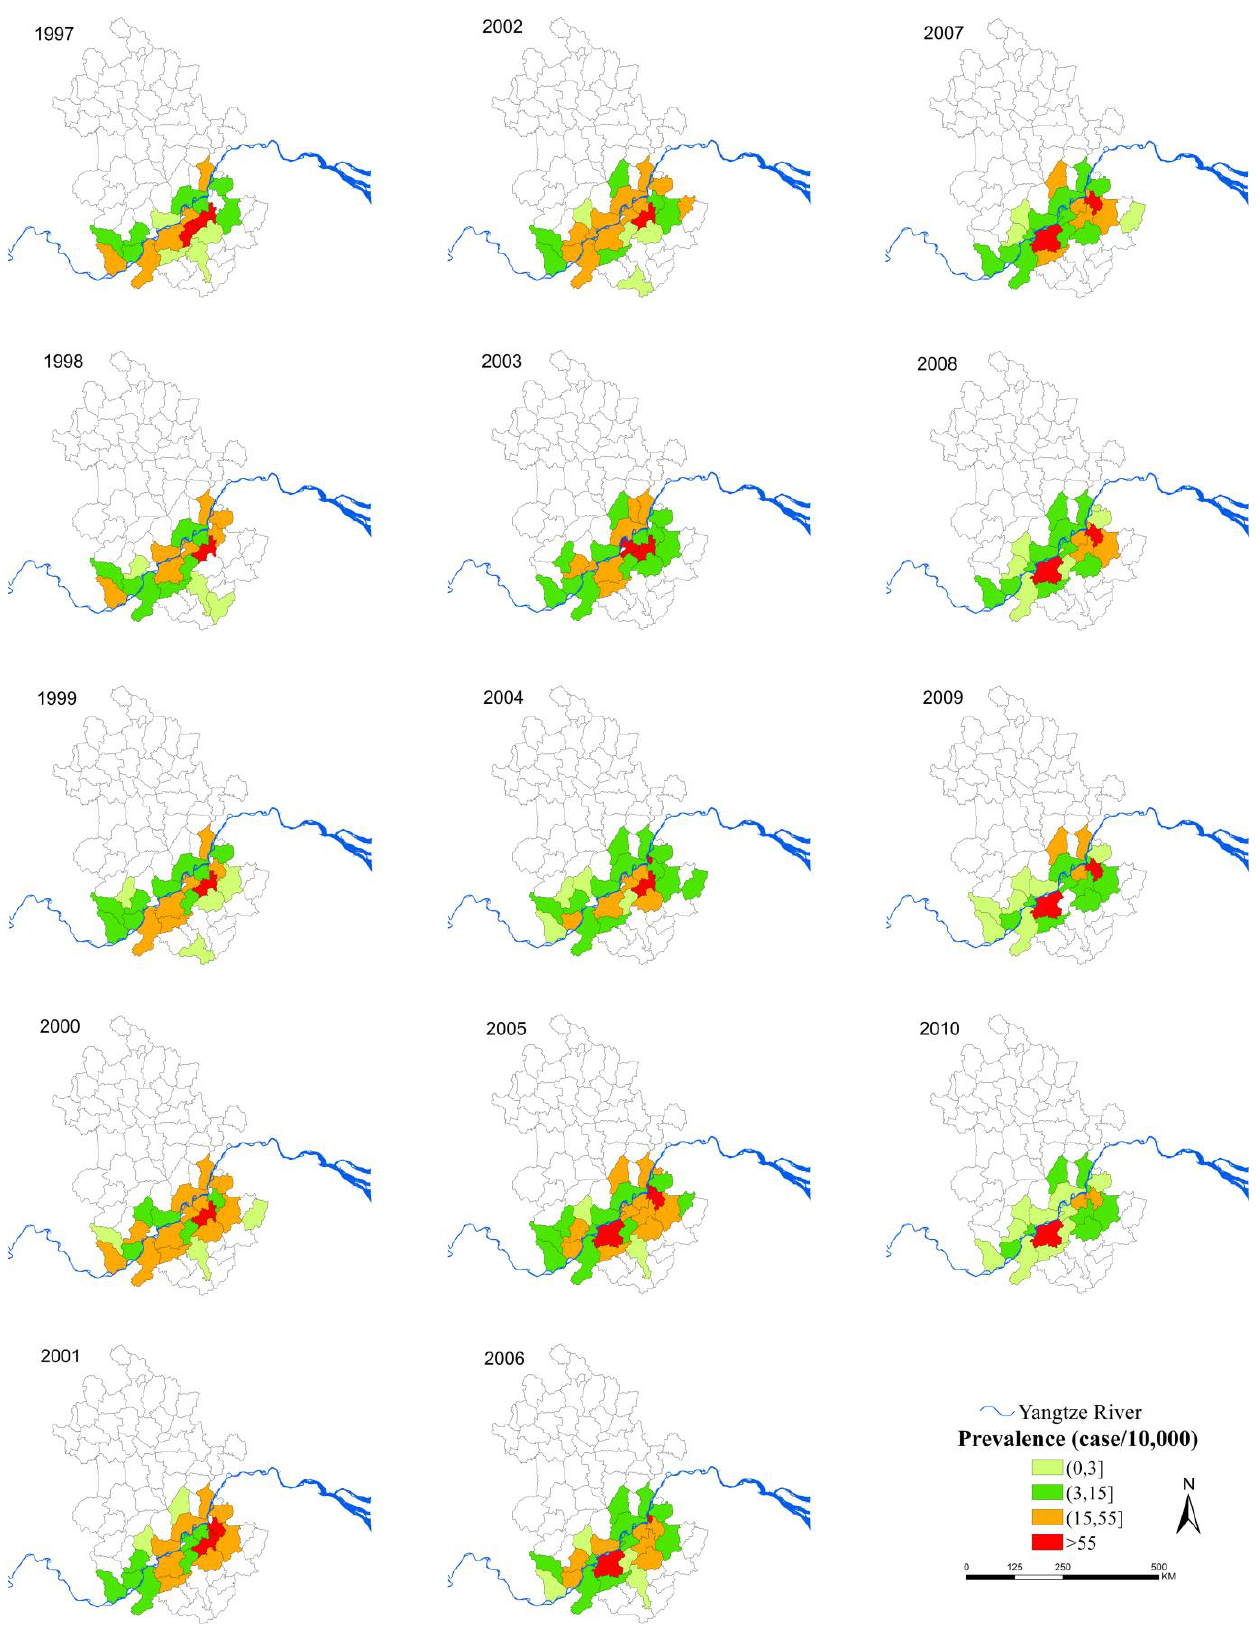
Figure 3. Annual prevalence of schistosomiasis at county level during 1997–2010. The maps were created using the ArcGIS 10.0 software (ESRI Inc., Redlands, CA,